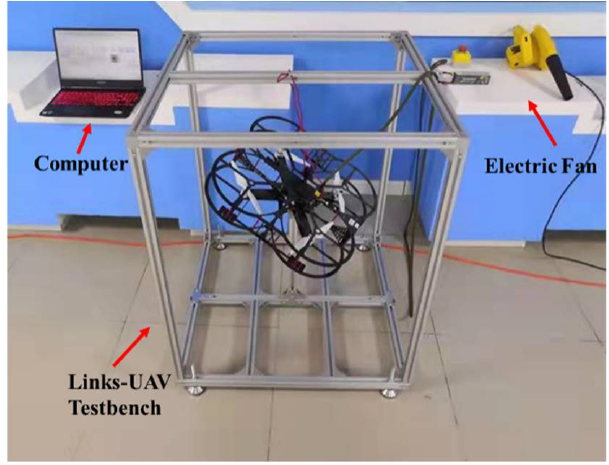
Figure 9. Links-UAV test bench.